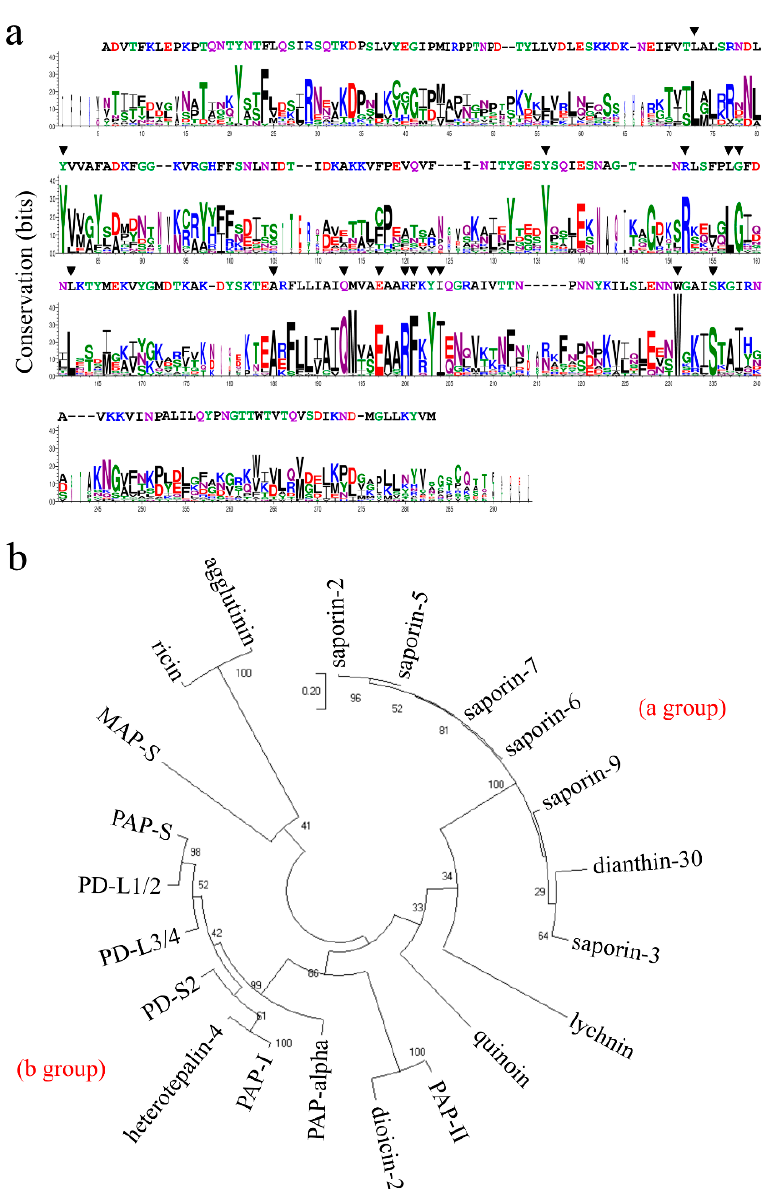
Figure 3. ( a ) Sequence logo between quinoin and ribosome-inactivating proteins. The sequence logo representation of the alignment of sequences (Figure S2) from 20 representative ribosome-inactivating proteins (Table S1) was created as indicated in the ‘Material and Methods’ section. Letter height is proportional to the conservation of that amino acid at that position in the alignment with respect to all the amino acids; letter width is proportional to the conservation of that amino acid but includes gaps. The colour of each amino acid is according to its chemical properties: polar (G, S, T, Y, C), green; neutral (Q, N), purple; basic (K, R, H), blue; acidic (D, E), red; hydrophobic (A, V, L, I, P, W, F, M), black. The sequence of quinoin is indicated above the logo. ▼ indicates the conserved amino acid residues in the alignment. ( b ) Molecular phylogenetic analysis by the Maximum Likelihood method of quinoin and 20 representative ribosome-inactivating proteins. The evolutionary history was inferred as indicated in the ‘Material and Methods’ section. The name of the ribosome-inactivating proteins is indicated, while the species and the accession numbers are reported in Table S1. All the sequences were retrieved and processed as indicated in the ‘Material and Methods’